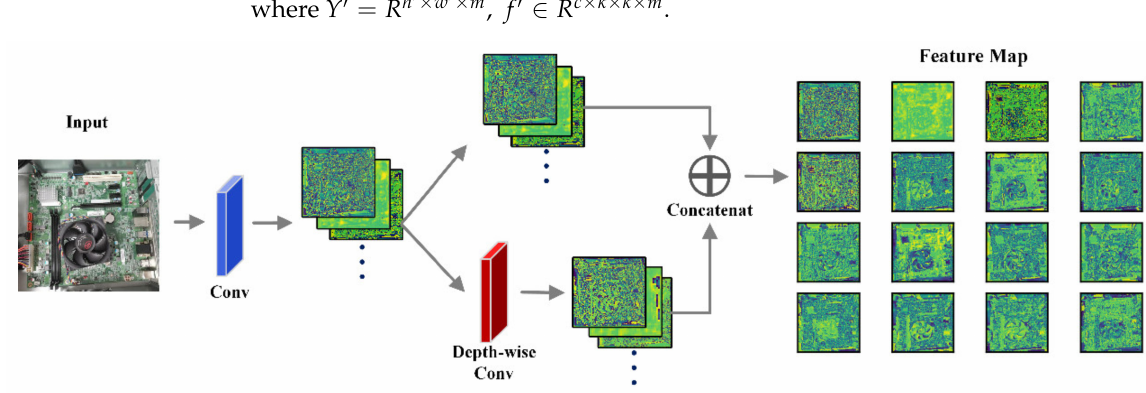
Figure 6. Ghost convolution